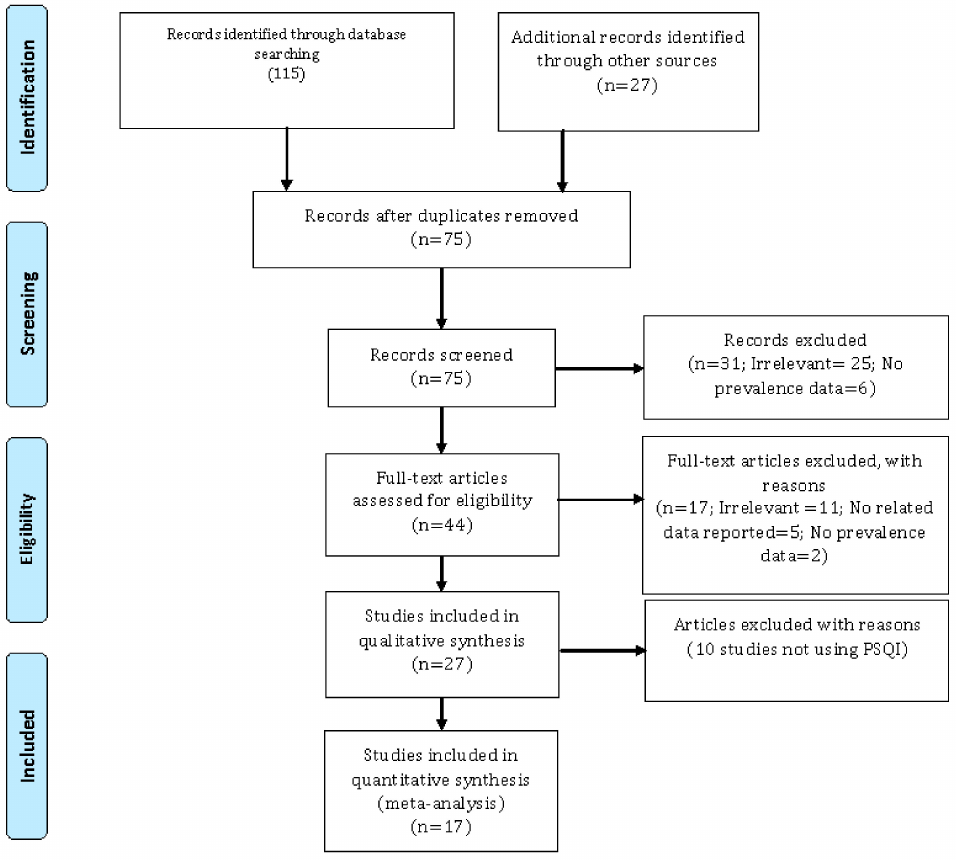
Figure 1. The process of study search, retrieval, and inclusion adopted in the present systematic review and meta-analysis concerning the prevalence rate of sleep disturbances among Iranian medical and allied healthcare professions students. Only studies utilizing the “Pittsburg Sleep Quality Index” (PSQI) were retained.